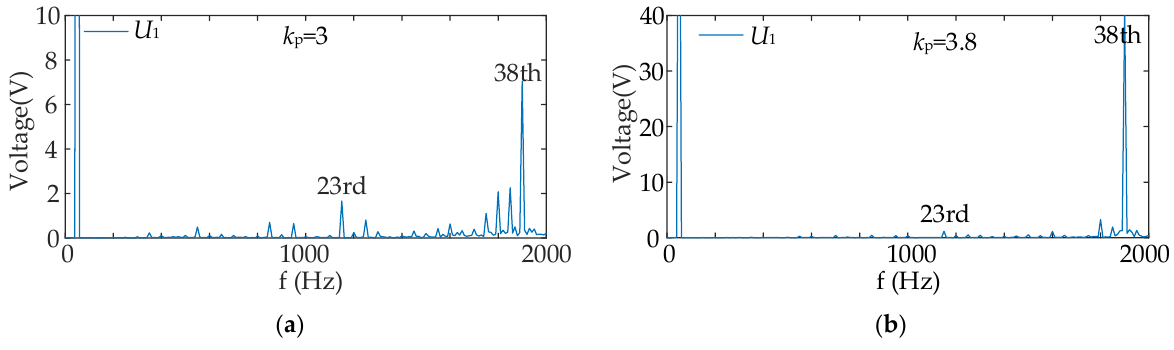
Figure 17. The node voltage spectrum when L 1 is changed: ( a ) L 1 = 0.8 mH; ( b ) L 1 = 1.6 mH. It can be seen from the spectrum change patterns that when the inductance L 1 of the inverter side increases, the resonant frequency of the low-frequency resonant part shifts from the 26th to the 22nd; the resonant frequency of the high-frequency part shifts from the 40th to the 38th; and the resonant frequencies all shift to the low, which is consistent with the results of the modal analysis as well as the frequency domain analysis. In the previous analysis of the effect of controller parameters, the influence of k p fluc- tuation on the resonance characteristics of the system was more obvious, so the variation of k p was taken for verification. In the simulation scenario with two inverters grid-connected, test currents of the 23rd and 38th harmonics are injected into the system at k p = 3 and 3.8, respectively, and the corresponding inverter node voltage spectrum changes are shown in Figure 18a,b.